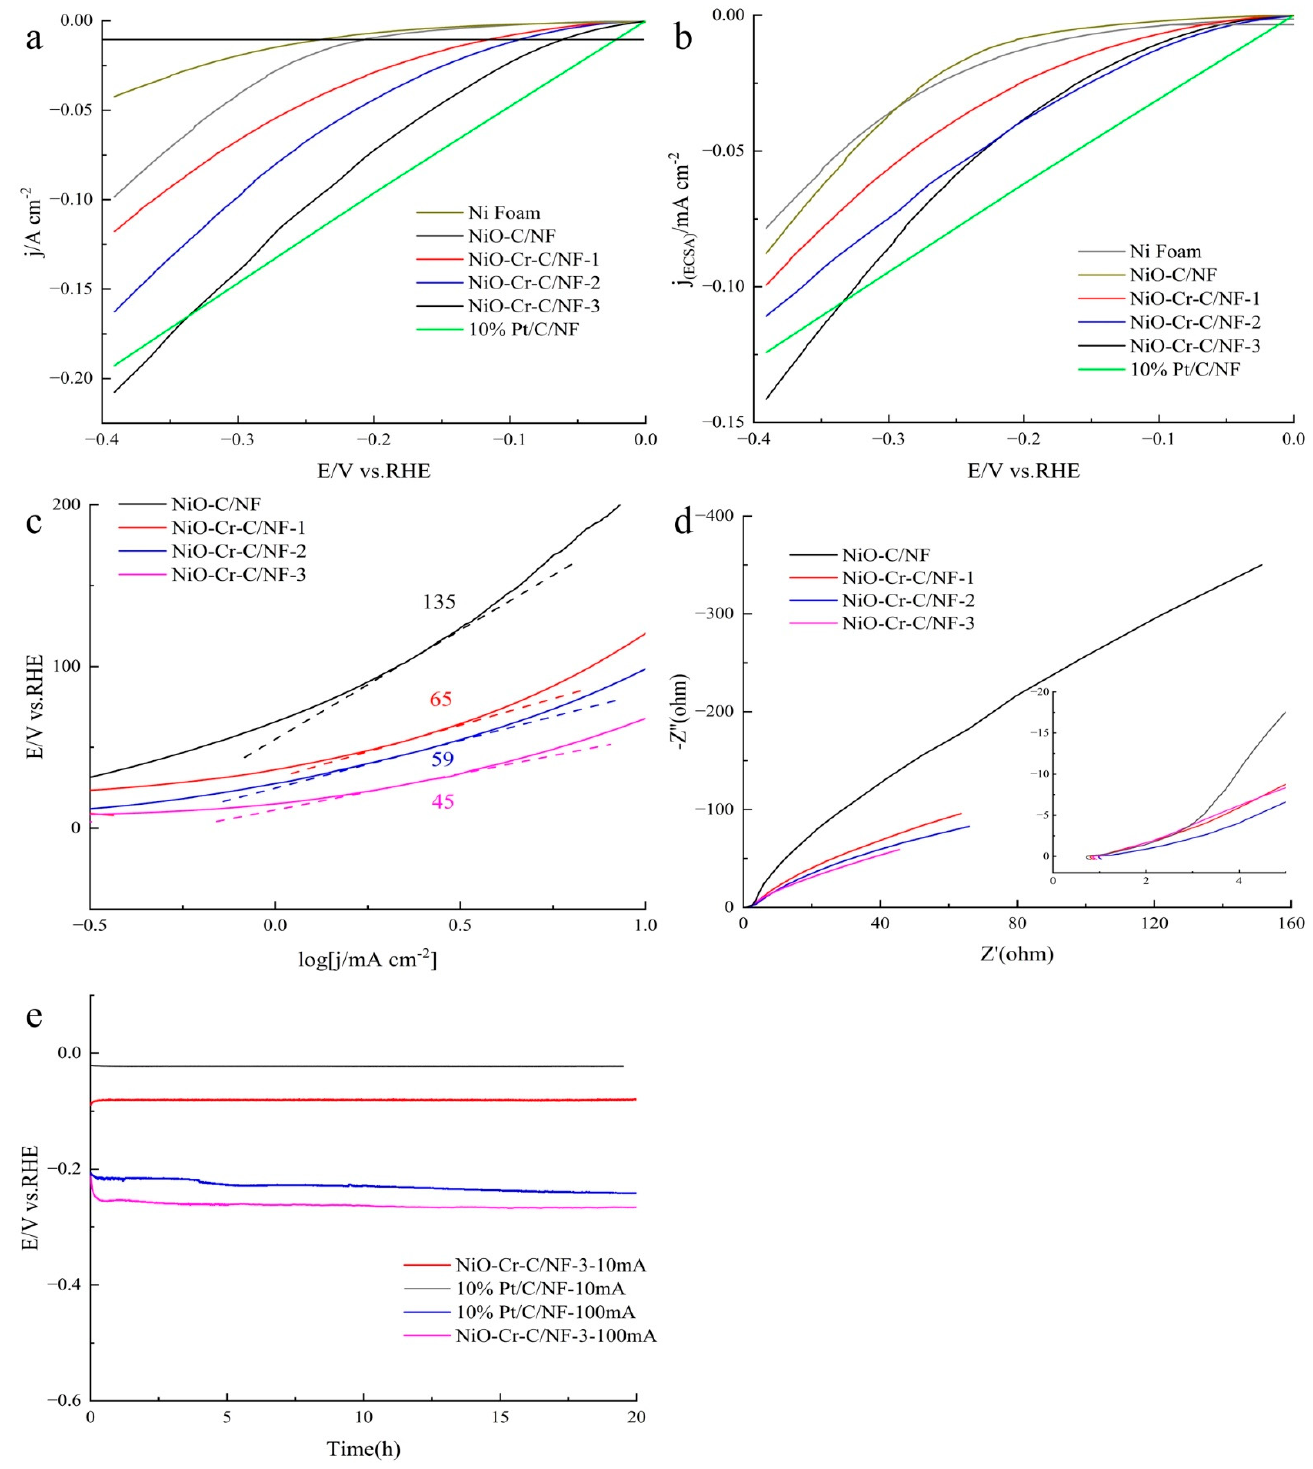
Figure 4. ( a ) HER polarization curves. ( b ) HER polarization curves after ESCA normalized. ( c ) Po- larization curve derived Tafel plots ( d ) Electrochemical impedance spectra of prepared samples. ( e ) Chronopotentiometric curve of NiO-Cr-C/NF-3.